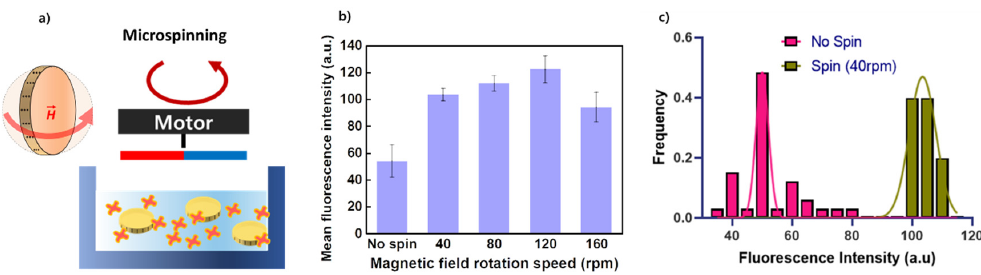
Figure 4. The optimization of magnetic field rotation speed. ( a ) A schematic of micromixing by microparticle spinning under a rotating magnetic field ( b ) The reaction efficiency was quantitatively measured to determine the appropriate conditions for the rotating speed of the external rotating magnetic field. ( c ) The distribution of fluorescence intensity of microparticles from the dataset between the groups of “No spin” and “40 rpm” from ( b ).